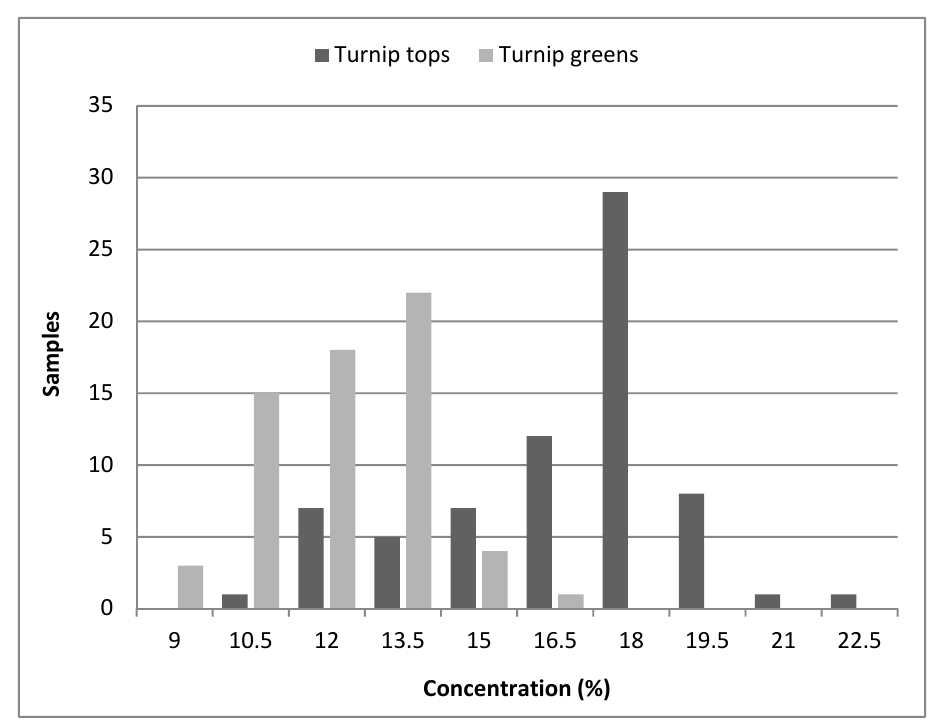
Figure 2. Distribution plot for ADF content in turnip greens and turnip tops.